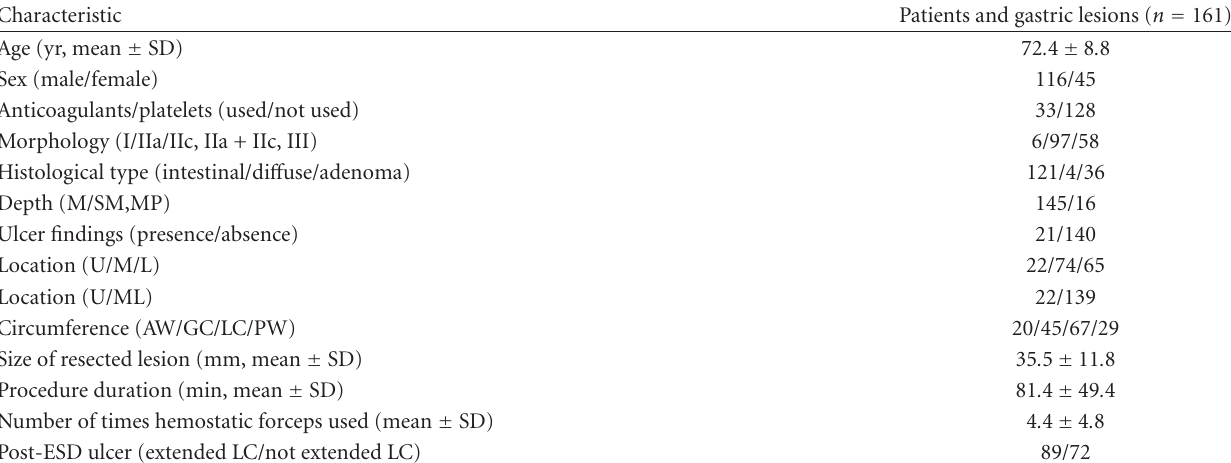
Table 1: Baseline characteristics of patients and gastric lesions.